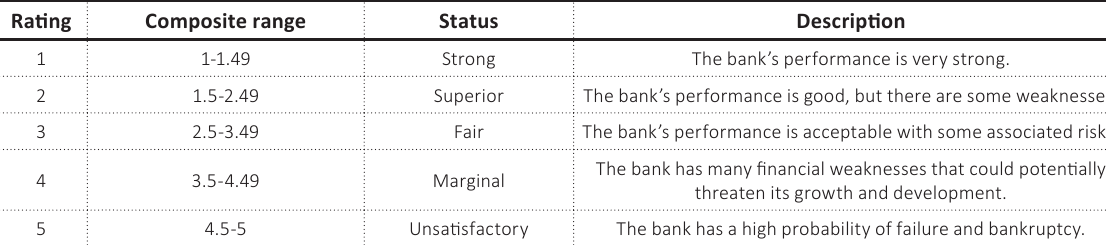
Table 3. Composite rating based on